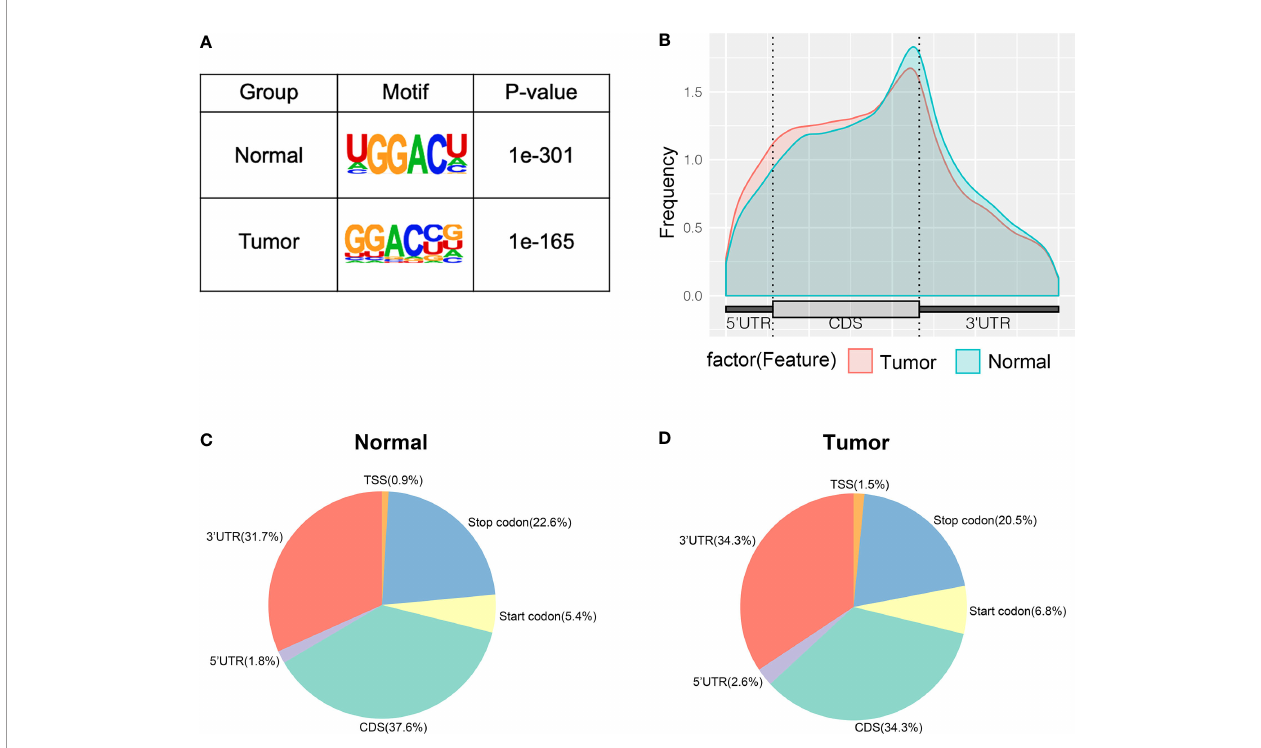
FIGURE 2 | Characteristics of m 6 A peaks within mRNAs, lncRNAs, and circRNAs in bladder cancer tissues and adjacent normal tissues. (A) Sequence motif of m 6 A-containing peak regions in tumor and adjacent normal tissues respectively. (B) The metagene pro fi les of transcripts peaks in tumor and adjacent normal tissues. (C, D) The proportion of m 6 A peaks in the whole transcriptome of tumor and adjacent normal